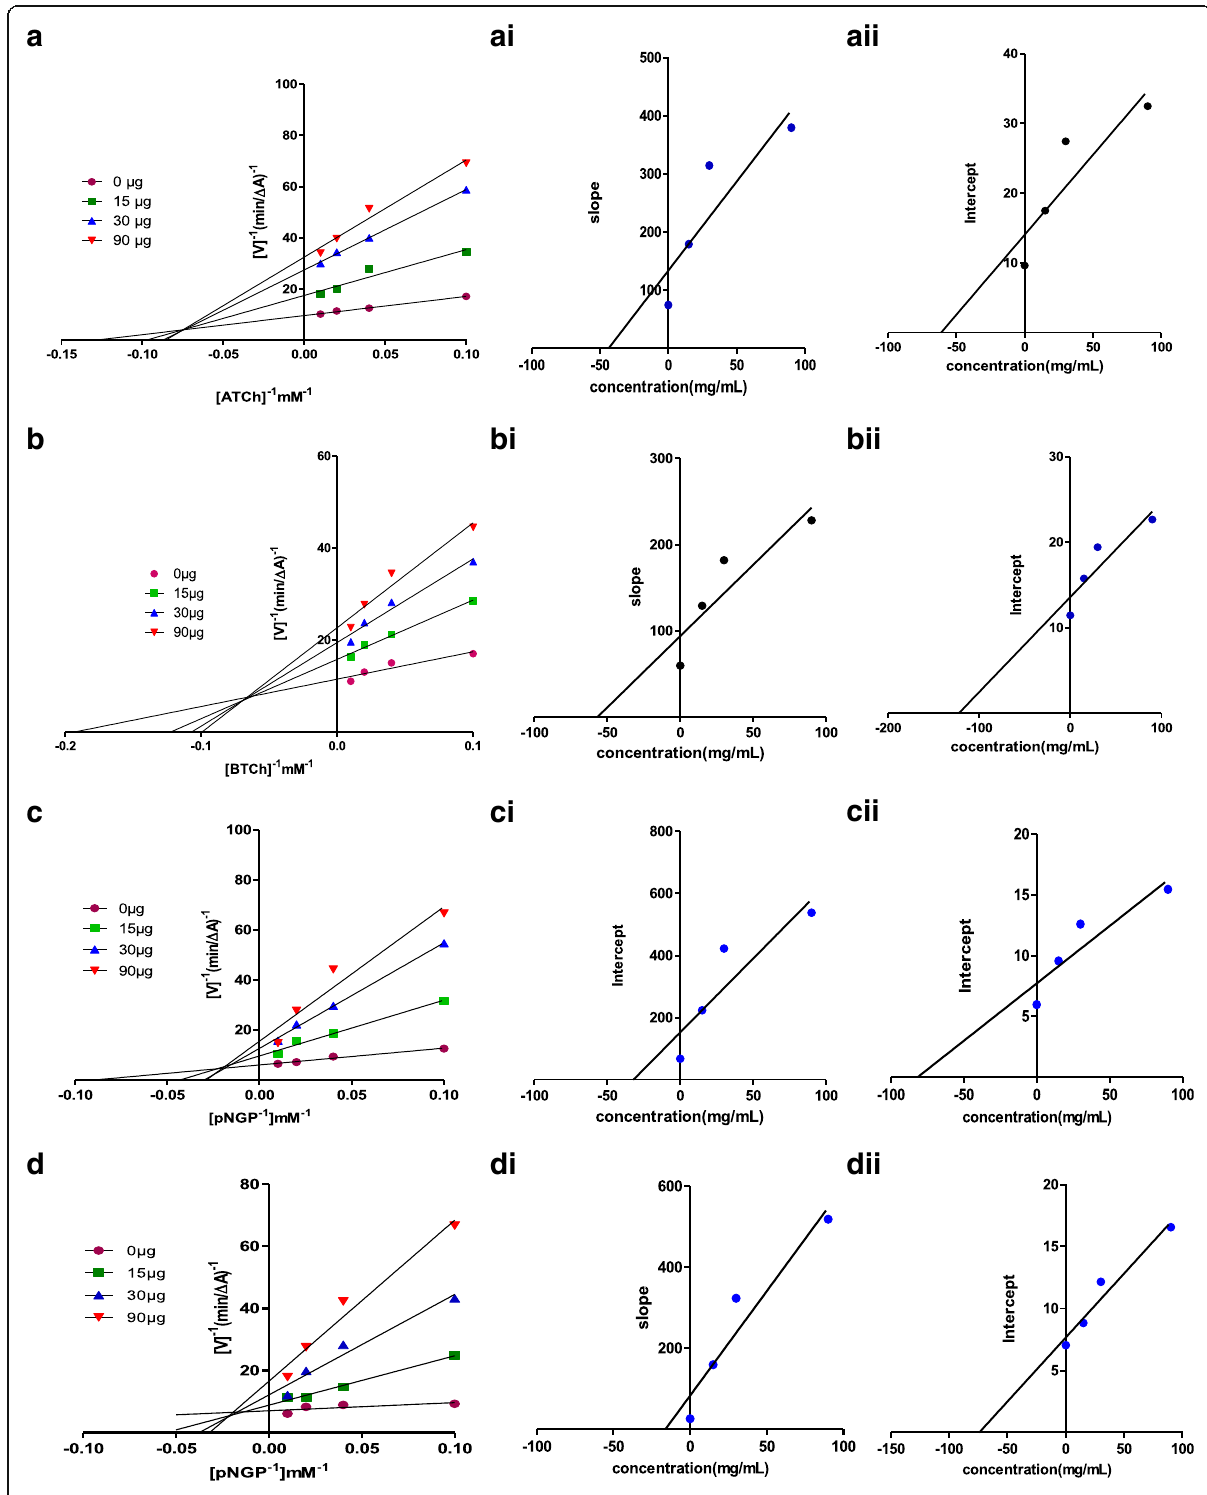
Fig. 2 Steady-state inhibition of AChE ( a ), BChE ( b ), α – Glucosidase ( c ) and β – Glucosidase ( d ) by most active fraction (BAC) from B.axillaris. (Left) Double reciprocal (1/V vs. 1/S) Lineweaver Burk plots; (right) secondary plots for inhibition constant Ki 1 (I) (slope vs. various concentrations of BAC) and for inhibition constant Ki 2 (II) intercept vs. various concentrations of